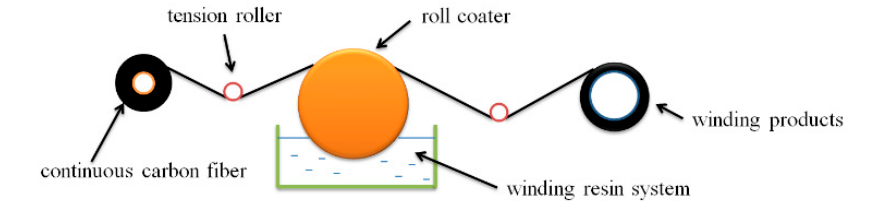
Figure 2. Filament winding process of NOL